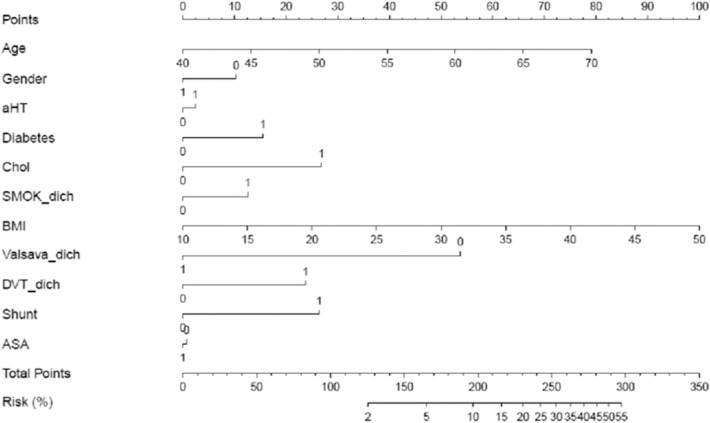
Nomogram: Likelihood of prior stroke in patients with cryptogenic stroke and PFO. Draw a line up perpendicular from the corresponding axis of each predictor variable to the top line labeled “points.” Sum up the number of points for all predictor variables to receive “total points. Now, draw a line descending from the “Total Points” axis until it intercepts the “Risk (%)” axis to estimate the likelihood of prior stroke.